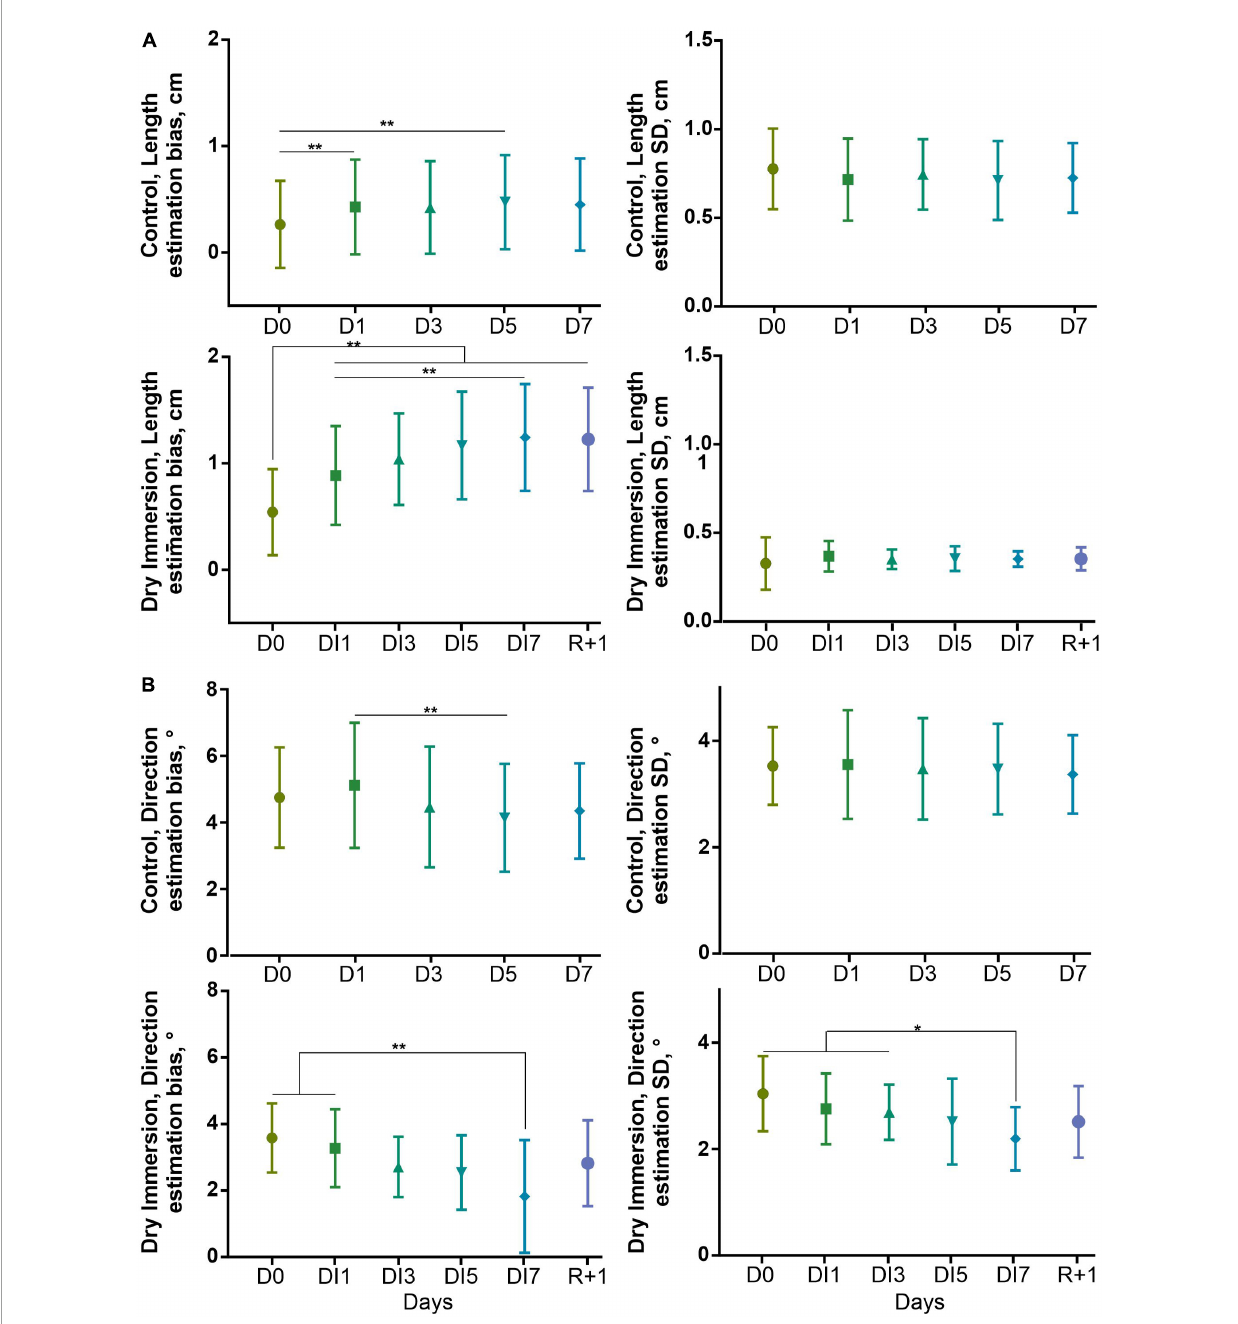
FIGURE4 Bias and SD of estimation of length (all orientations), (A) and direction (non-cardinal segments), (B) at reproduction stage in control ( n = 22) and DI ( n = 10) groups. The bias of length estimation was calculated as mean non-cardinal segment length estimation error. The directional bias was calculated as (O 22 . 5 +O 112 . 5 –O - 22 . 5 –O 67 . 5 )/4 where O is a direction error of given participants for given direction. D0–1st day of measurements in control and DI groups. D1, D3, D5, and D7–2nd, 4th, 6th, and 7th day of measurements in the control group, respectively. These days correspond to DI1, DI3, DI5, and DI7–1st, 3rd, 5th, and 7th day of DI. R + 1–the measurement performed 1 day after the end of the DI procedure. Mean ± SD. ** p < 0.01, * p <